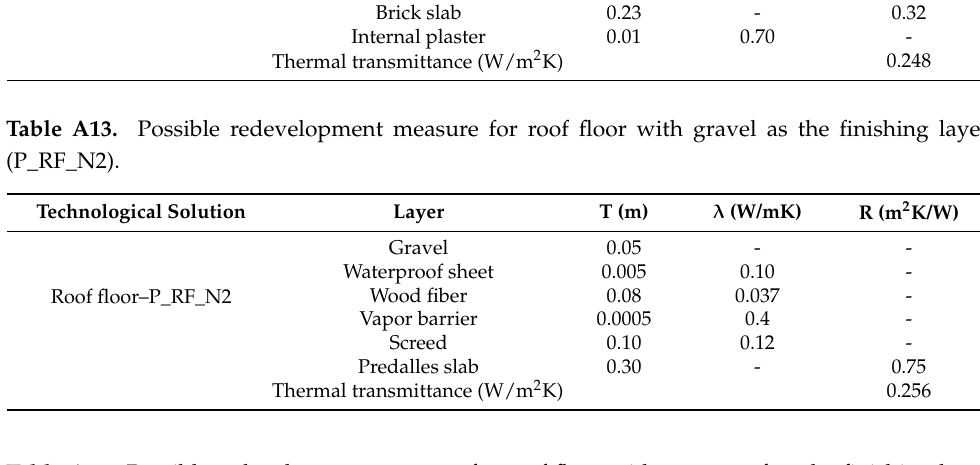
Table A14. Possible redevelopment measure for roof floor with green roof as the finishing layer